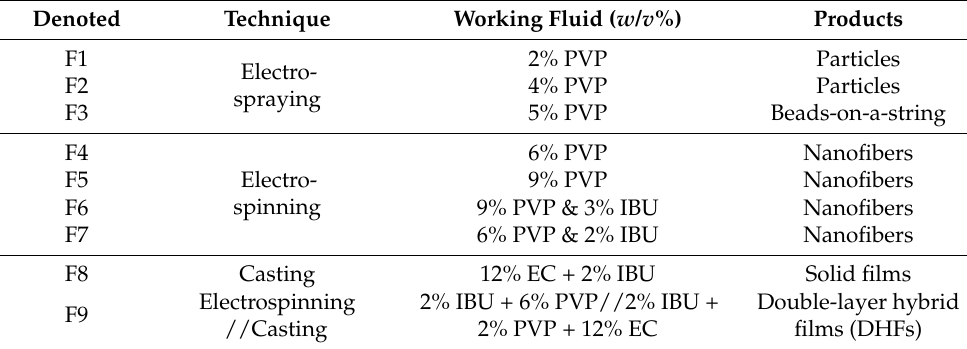
Table 1. Data for preparations and